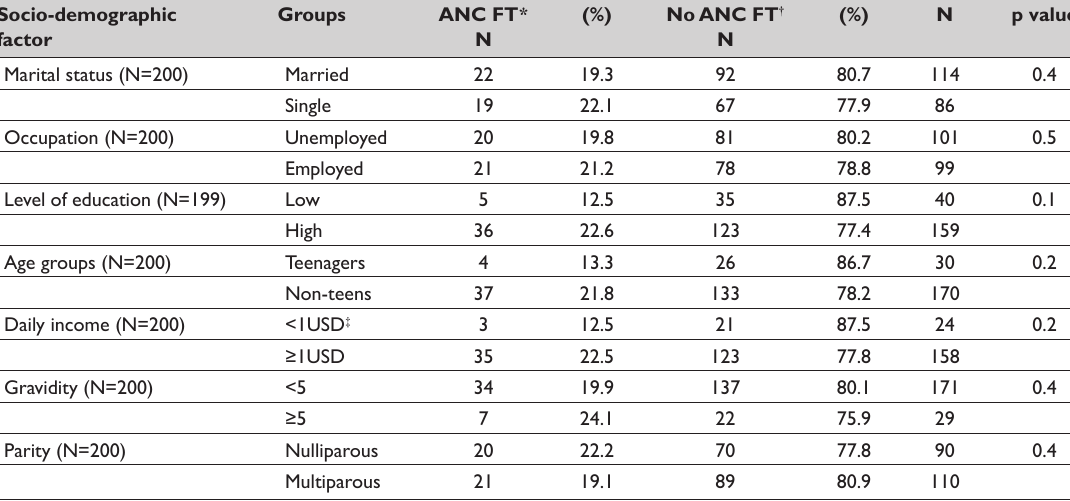
Table 1: Socio-demographic characteristics and obstetric history of mothers delivering in the Buea Regional Hospital, January – March 2013